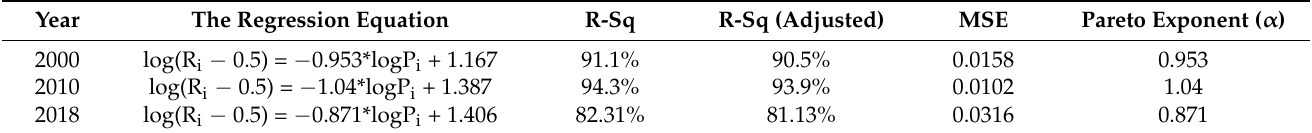
Figure 5. The Zipf plot for KMA in 2000–2018. Table 4. The relevant parameters of the rank ‐ size rule fitting in the KMA.